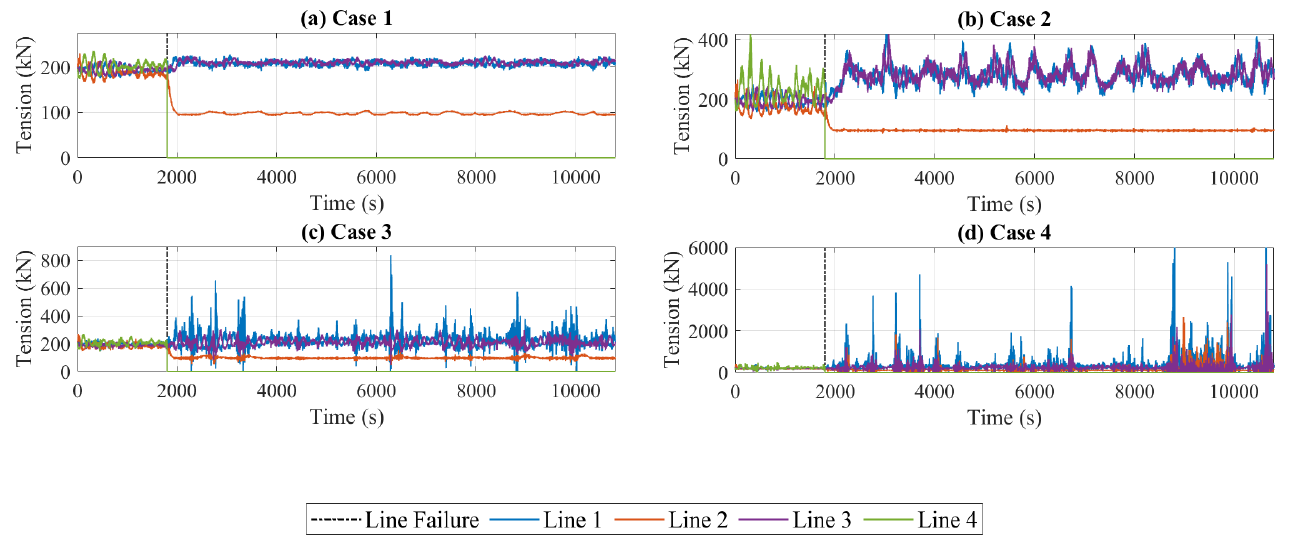
Figure 15. Mooring line tensions pre- and post-failure of Line 4 at 1800 s for ( a ) Case 1, ( b ) Case 2, ( c ) Case 3, and ( d ) Case 4.